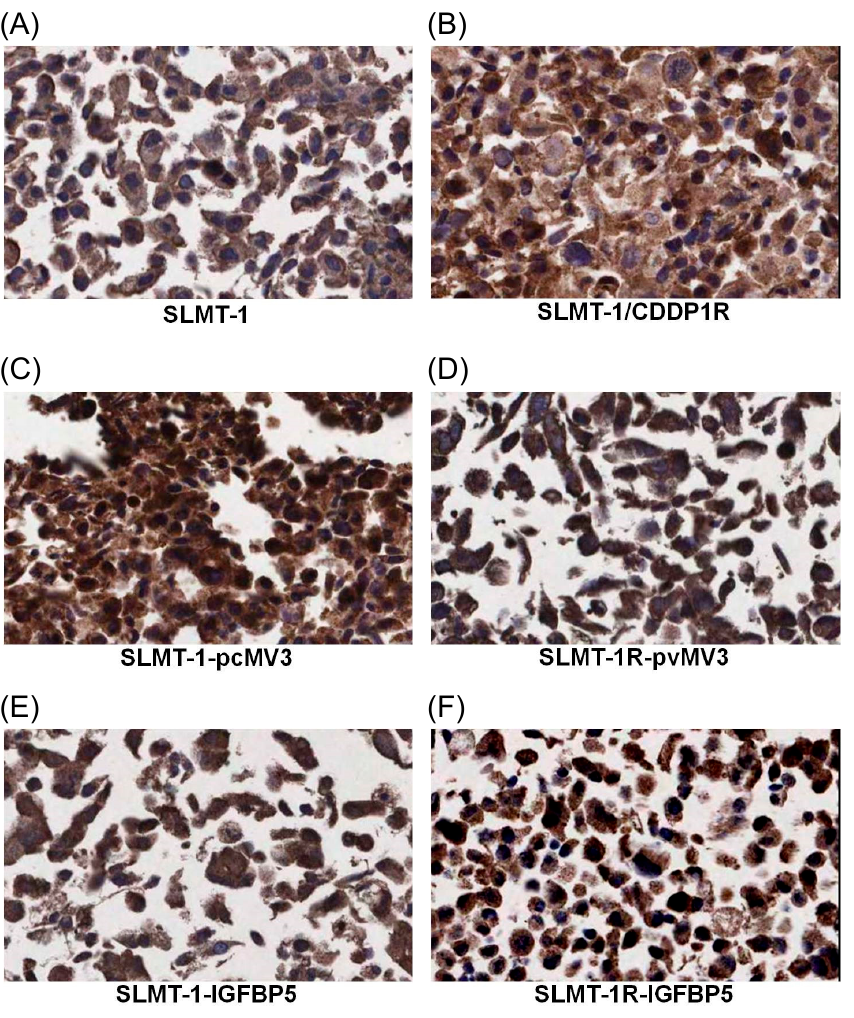
Figure 4. Immunohistochemical staining of Myc-tagged pcMV3 vector in ( A ) SLMT-1. ( B ) SLMT-1/CDDP1R. ( C ) SLMT-1-pcMV3. ( D ) SLMT-1R-pcMV3. ( E ) SLMT-1-IGFBP5 and ( F ) SLMT-1R-IGFBP5 cells showed the transfection efficiency of IGFBP5 and pcMV3 mock vector. More positive staining nuclear and cytoplasmic signals (>50%) were observed in SLMT-1-pcMV3, SLMT-1R-pcMV3, SLMT-1-IGFBP5 and SLMT-1R-IGFBP5 than the untransfected SLMT-1 and SLMT-1/CDDP1R cells. Original magnification: ×400.